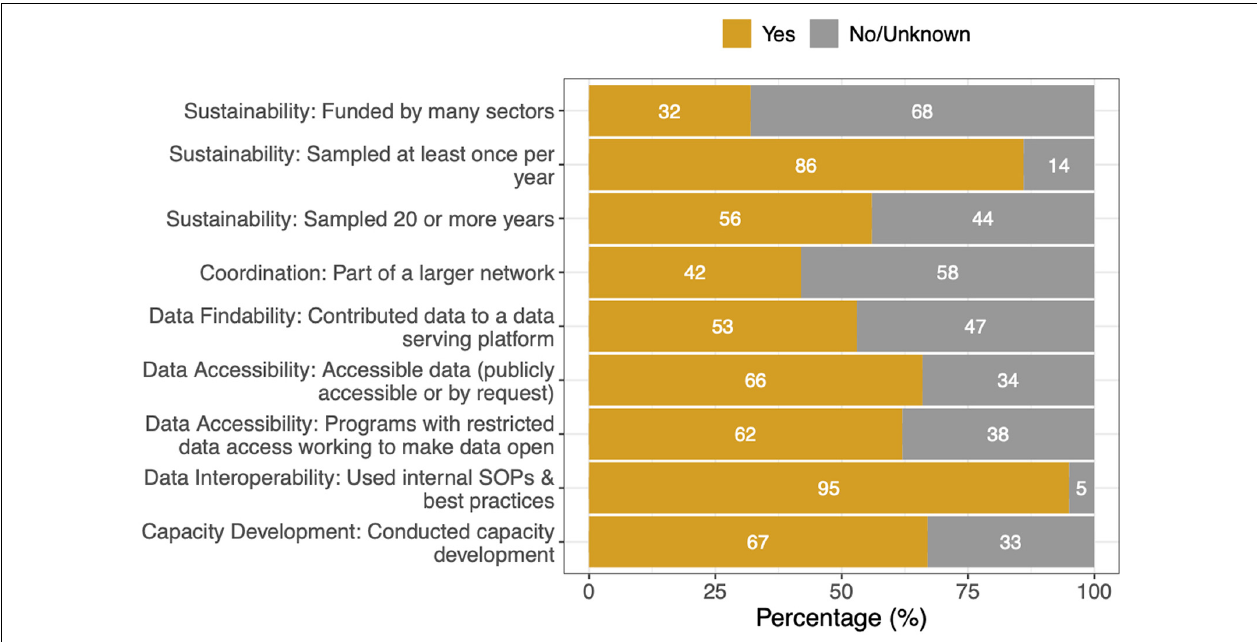
FIGURE 4 | Bar plot based on survey responses displaying the 203 active, long-term observing programs sustainability (based on funding, sampling frequency, and duration), coordination, data management (including findable, accessible, and interoperable data), and existing capacity development